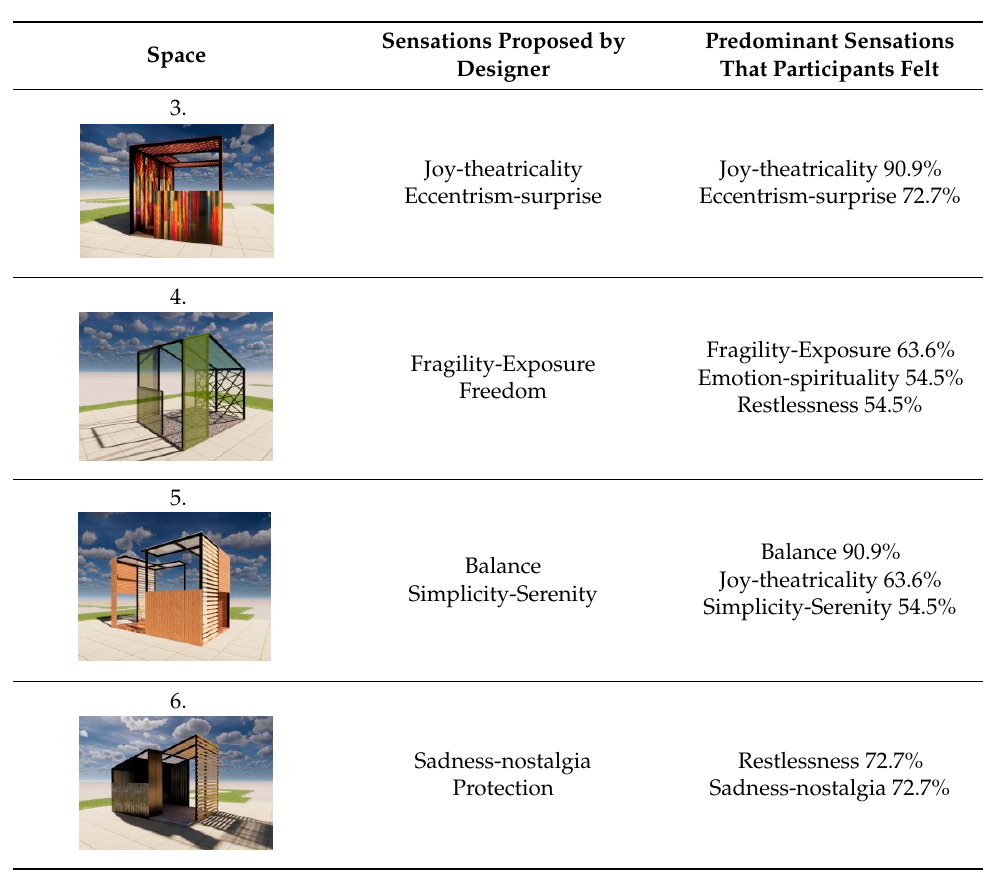
Table 7. Most representative perceived sensations.